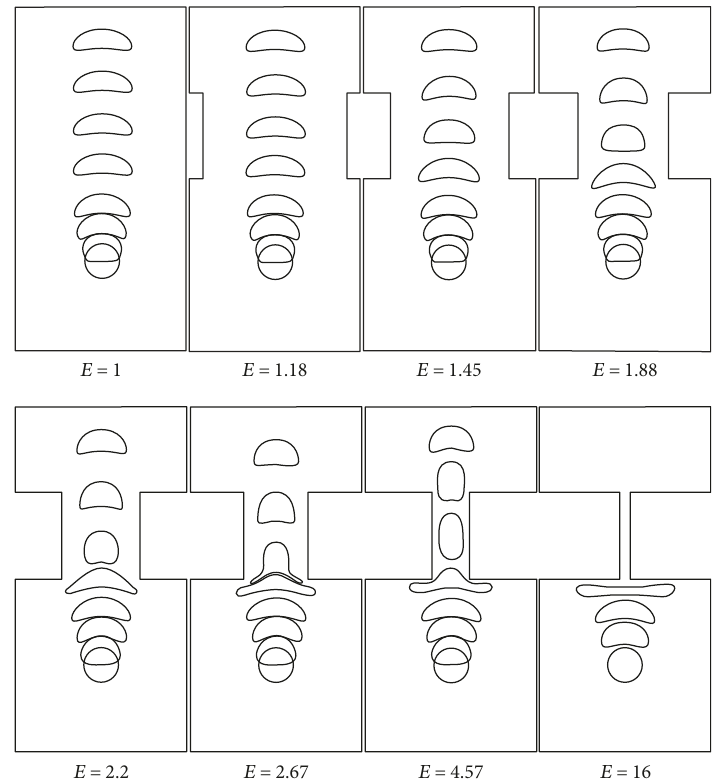
Figure 4: Free rise of the bubbles in di ff erent contractive channels (Re =28.2, Eo=16, and Mo =0.01).